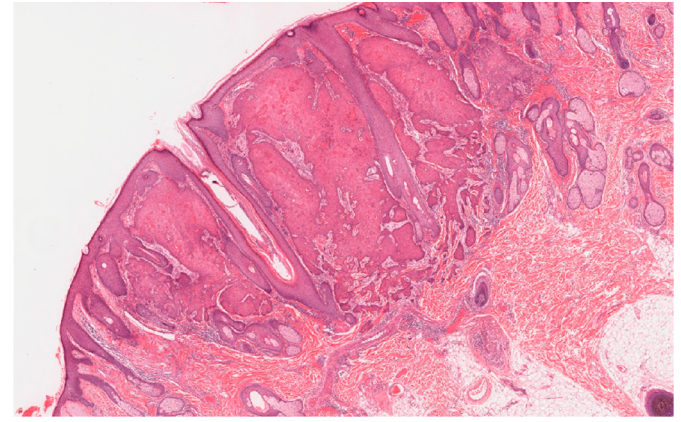
Figure 2. A multiple self-healing squamous epithelioma (MSSE) tumor that has the histological appearance of a well differentiated squamous cell carcinoma with invasion of the reticular dermis.